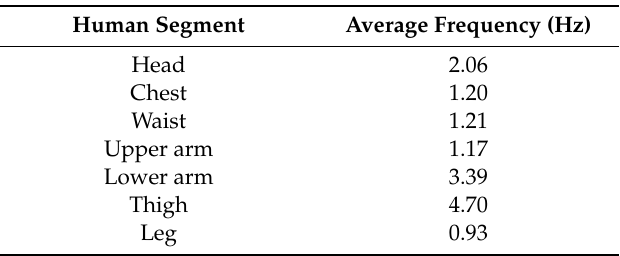
Table 1. Average frequencies of human segments.